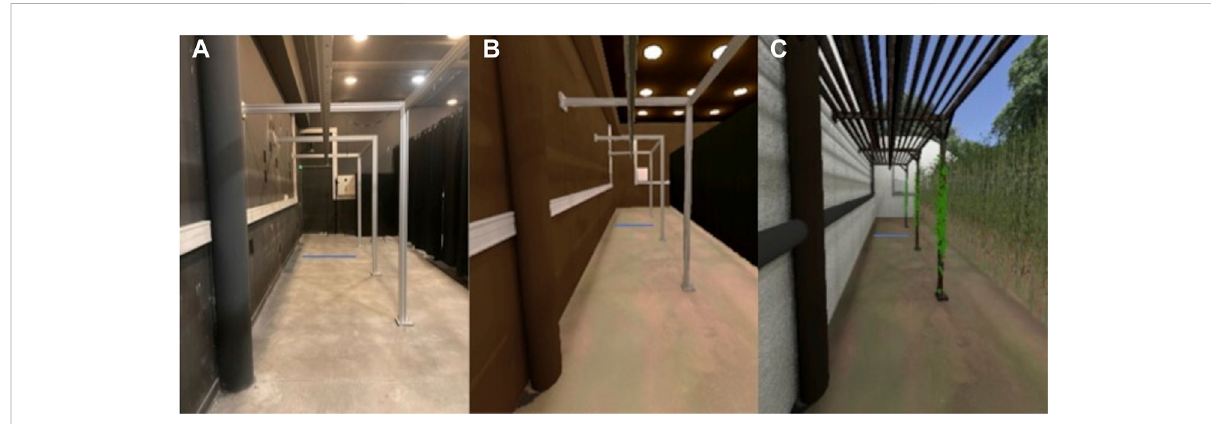
FIGURE 4 Experimental conditions. (A) Picture of the “ real-world condition ” . (B) Screen shot of the “ corresponding virtual reality condition ” . (C) Screen shot of the “ outdoor virtual reality condition ” .